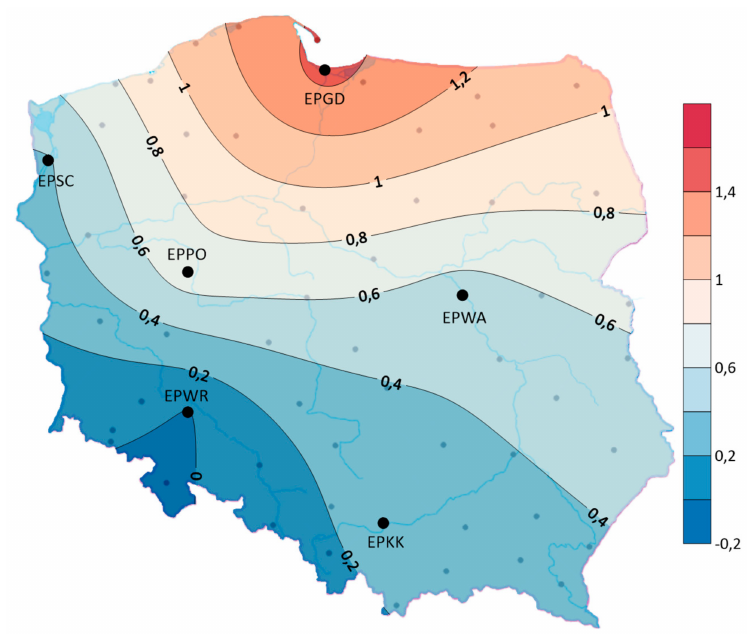
Figure 6. The distribution of the linear trend indicator for the average annual number of days with a storm (days / 10 years), (1970–2018).